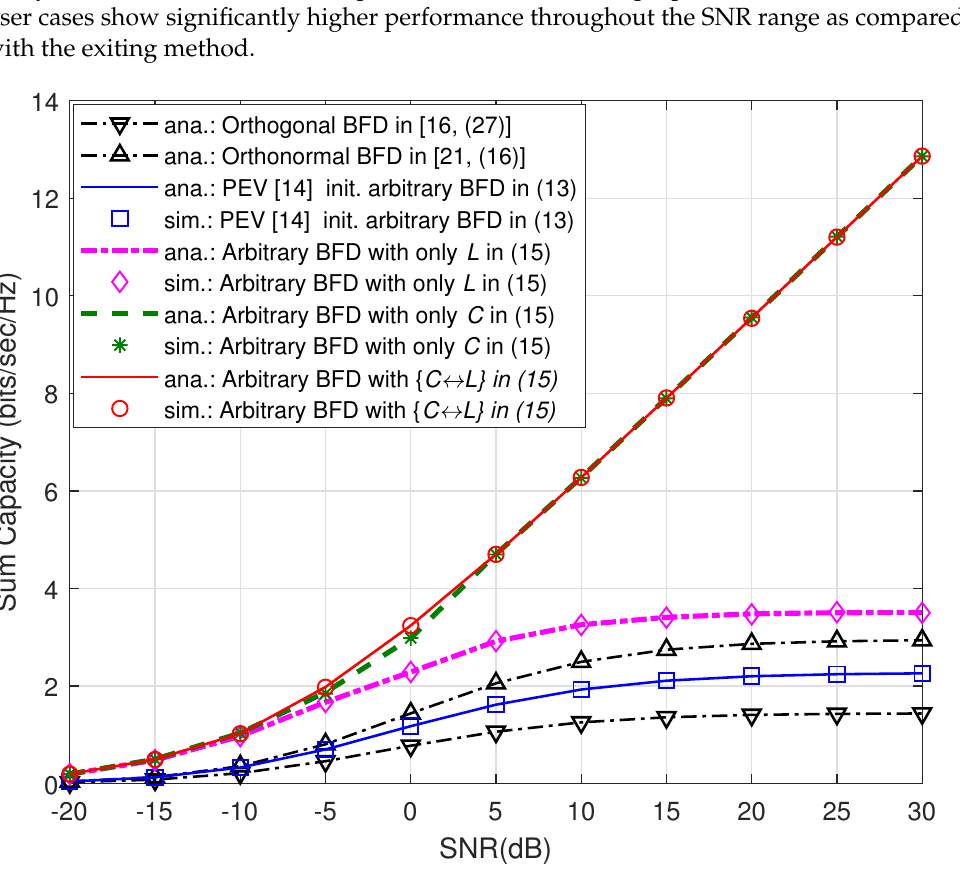
Figure 5. Comparison of analytical and simulation results of the sum capacity versus the transmit SNR in dB under several beamformer designs